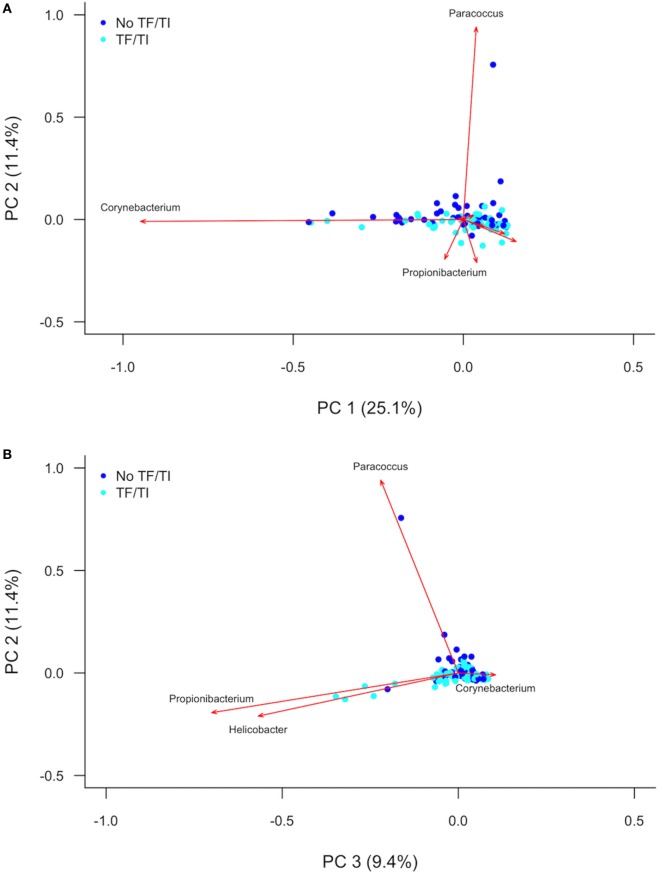
(A) First and second and (B) second and third principal components describing variation between the 16S sequences identified in Solomon Island children with and without active trachoma. Dark blue spots indicate controls. Light blue spots indicate cases. Red arrows show principal component loadings. PC, principal component; TF, trachomatous inflammation–follicular; TI, trachomatous inflammation—intense.